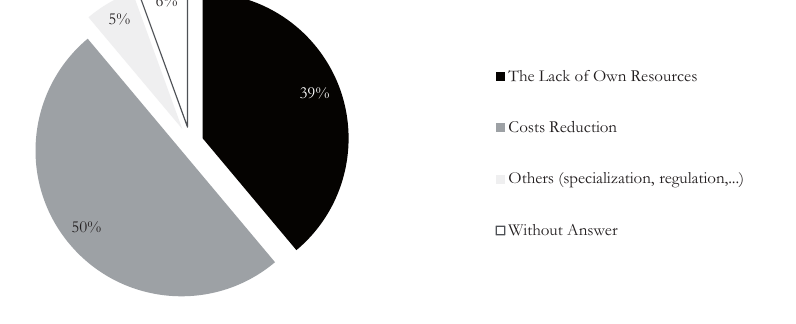
Fig. 2 – Reasons for Logistics Outsourcing. Source: Authors´